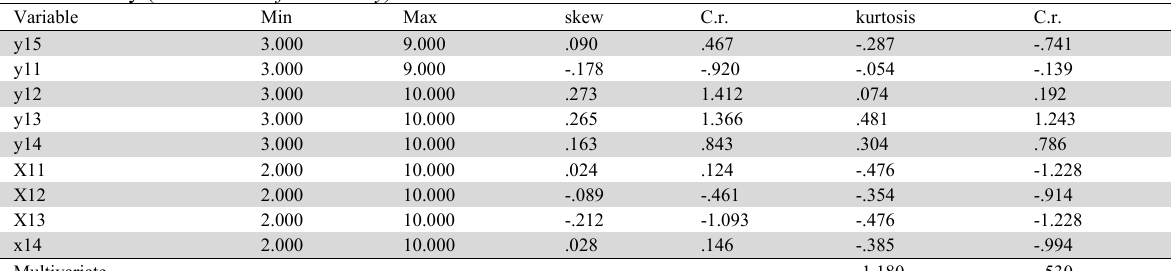
Test Normality ( Assessment of Normality)